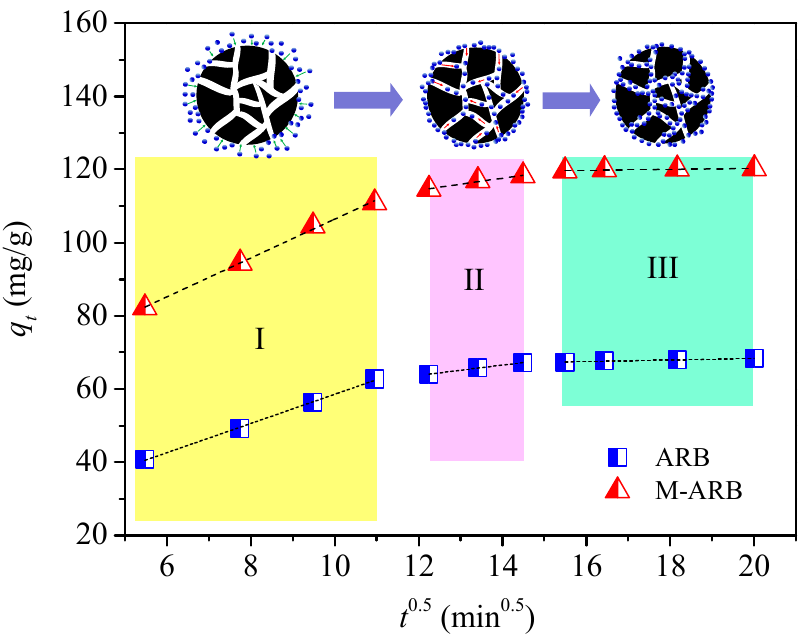
Figure 8. Segmented fit of the Weber–Morris model. Table 3. Segmented fit parameters of the Weber–Morris model.